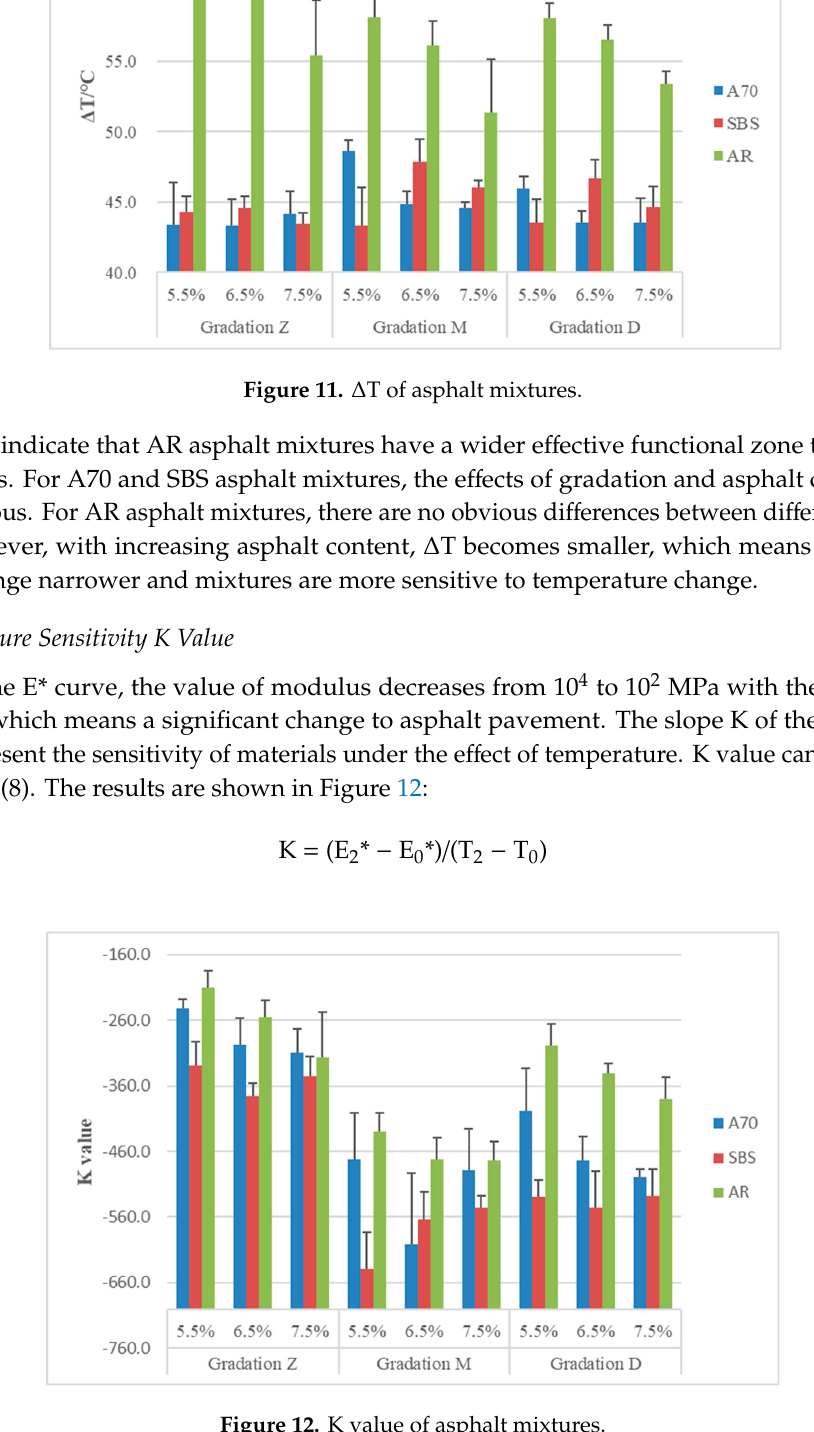
Figure 12. K value of asphalt mixtures.